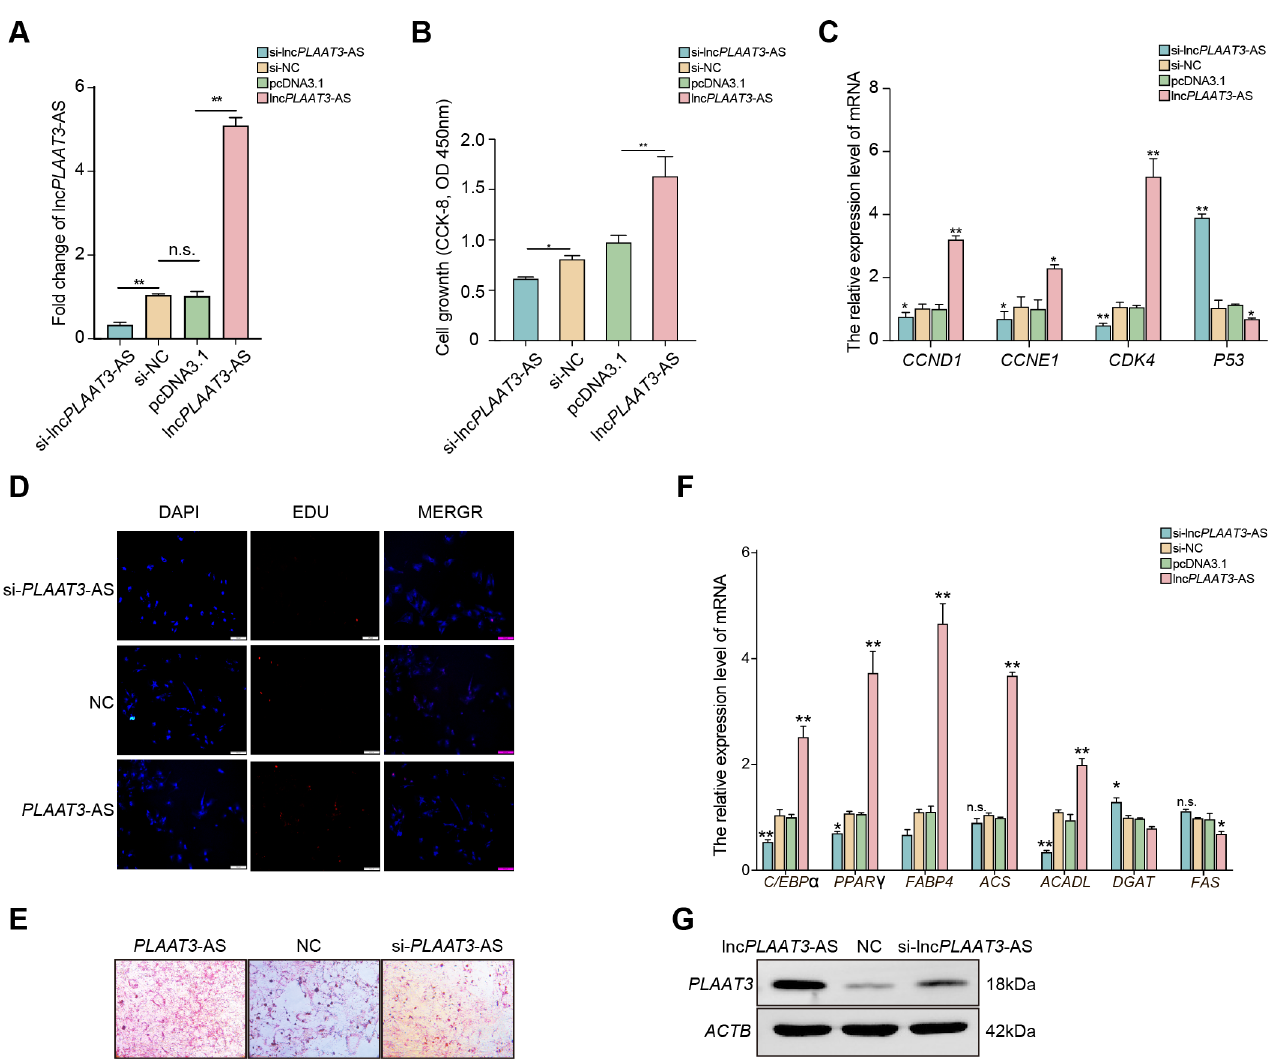
Figure 1. Lnc PLAAT3 -AS promotes preadipocyte proliferation and differentiation. Primary adipocytes were transfected with a lnc PLAAT3 -AS overexpression plasmid, an siRNA against lnc PLAAT3 -AS (si-lnc PLAAT3 -AS), or a negative control (si-NC) construct; ( A ) transfection efficiency was measured by qRT-PCR; ( B ) cell proliferation was evaluated by CCK-8 assay; ( C ) expression of genes associated with cell proliferation was measured by qRT-PCR; ( D ) representative images of an EdU assay of PK15 cells transfected with lnc PLAAT3 -AS mimics or lnc PLAAT3 -AS inhibitor; ( E ) oil red O staining; ( F ) expression of marker genes related to adipogenesis, fatty acid oxidation, and fatty acid transportation synthesis (scale bars 100 µ m); ( G ) PLAAT3 expression after transfection with each of the three constructs described above. All results are presented as means ± SEM; n = 3; * p < 0.05; ** p < 0.01; n.s., no significant